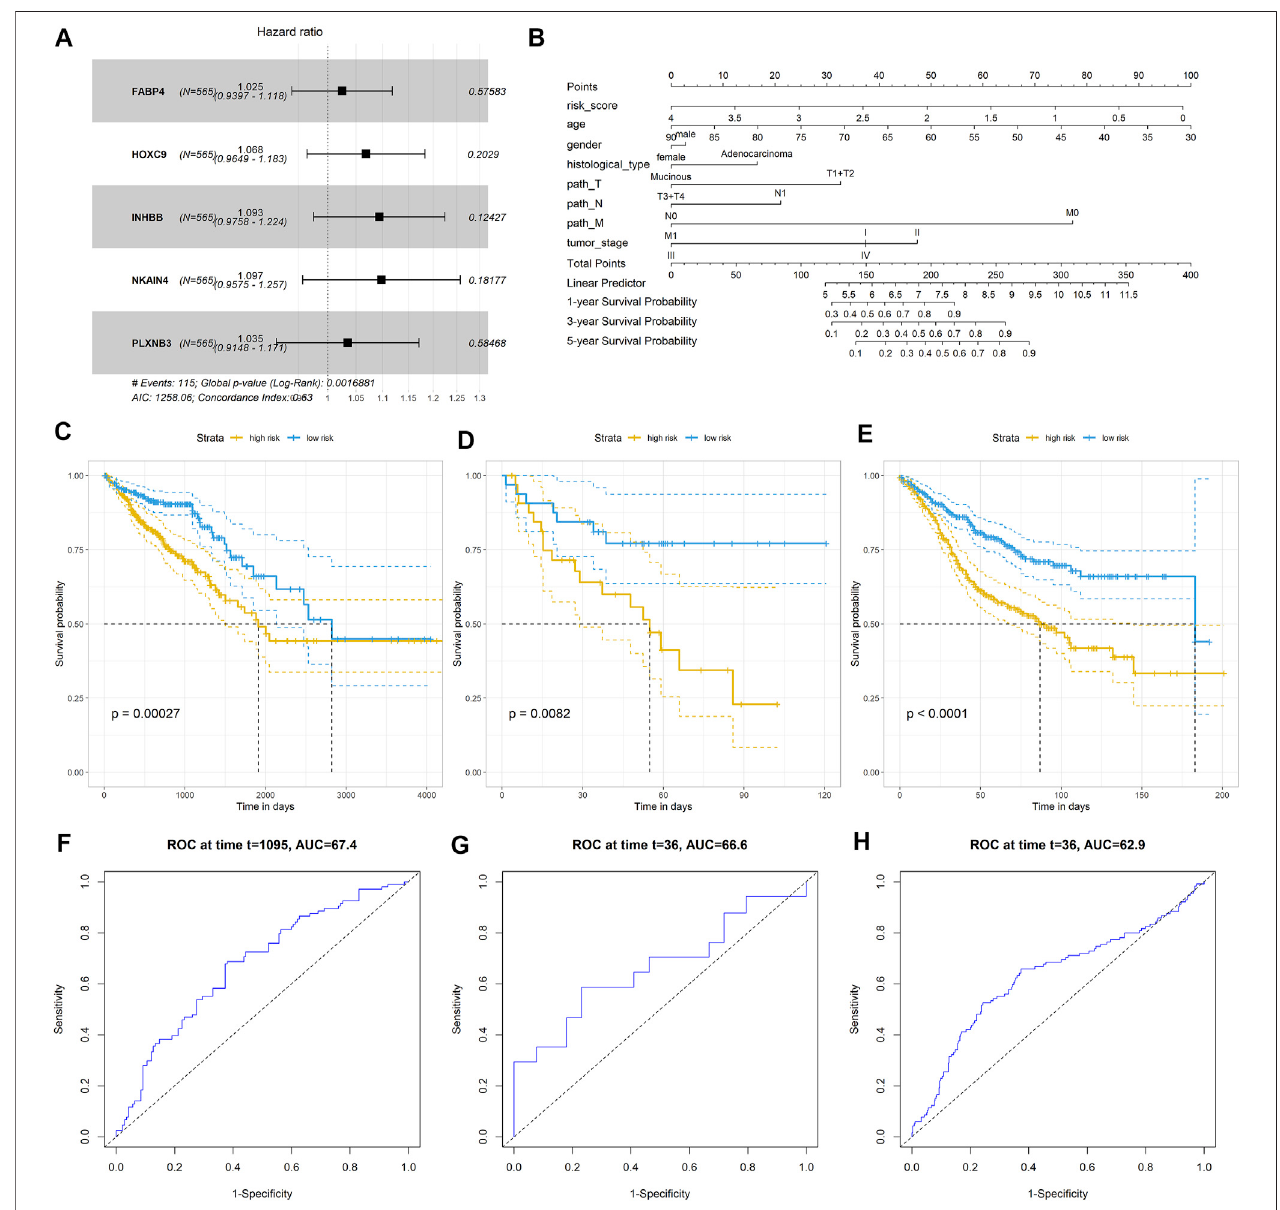
FIGURE 7 | Construction and validation of CRC predictor based on the stemness-related genes. (A) Forest plot showed that fi ve stemness- related genes associated with the prognosis of patients; (B) Nomogram plot of showed the prognostic value of the gene signature and other clinical features in CRC; Kaplan – Meier analysisindicatedthesurvivalratedofpatientswithhighorlowriskscoresin (C) TCGA-COADREAD dataset; (D) GSE29621dataset (E) GSE39582dataset;Prognostic value of the gene signature in (F) TCGA-COADREAD dataset; (G) GSE29621 dataset; (H) GSE36582 dataset.